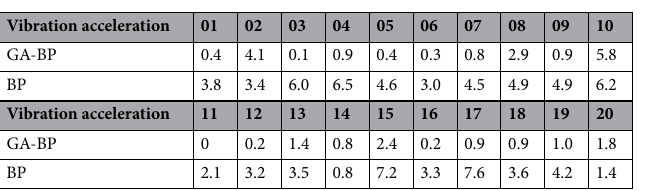
(a) Comparison of relative error of equipment lubrication (b) Comparison of relative error of vibration Figure 4. Prediction error.